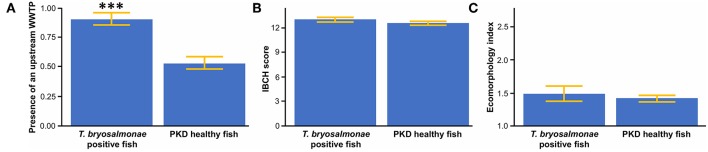
(A) Mean presence of an upstream wastewater treatment plant (WWTP) between T. bryosalmonae infected and PKD healthy fish. (B) Mean biological score (IBCH) between T. bryosalmonae infected and PKD healthy fish. (C) Mean ecomorphology index between T. bryosalmonae infected and PKD healthy fish. Yellow lines indicate standard error, asterisks indicate levels of significance (t-test), ***p < 0.001.